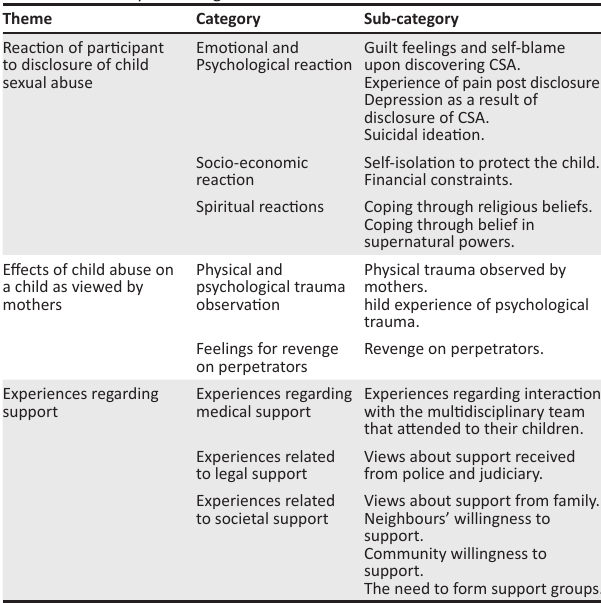
TABLE 1: Summary of